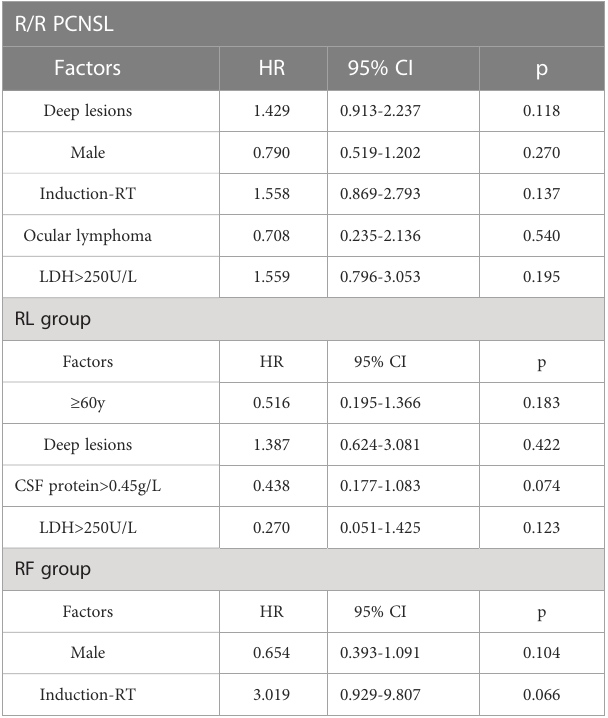
TABLE 2 Multivariate analysis of prognostic factors for initial recurrence or